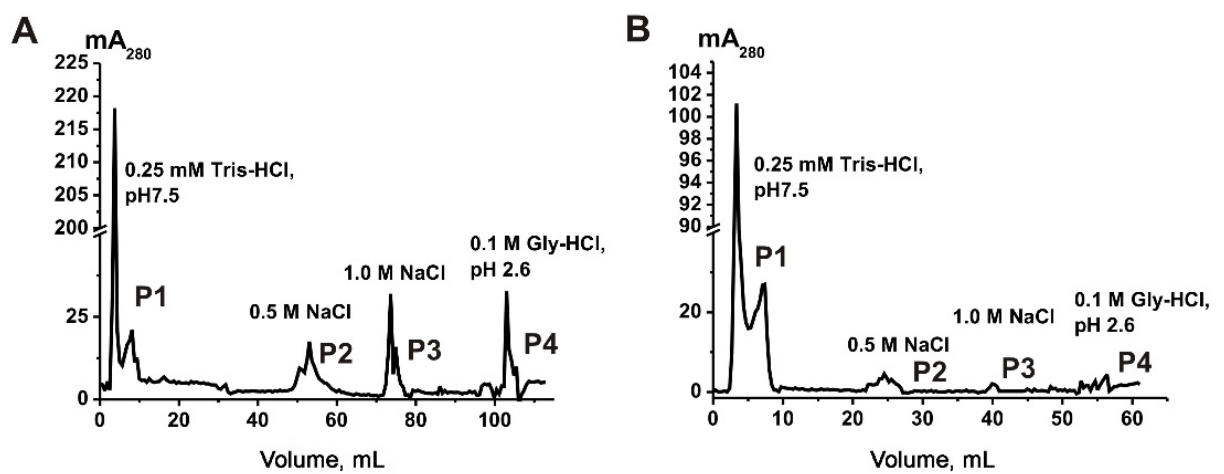
Figure 3. Affinity chromatography of VESmix on anti-CD9- ( A ) and anti-CD63-Sepharose ( B ). ( – )—absorbance on A 280 nm, mAU; P1—subfraction appeared in flow, P2—subfraction eluted with 0.5 NaCl, P3—subfraction eluted with 1.0 M NaCl, P4—subfraction eluted with 0.1 M Gly-HCl pH 2.6.